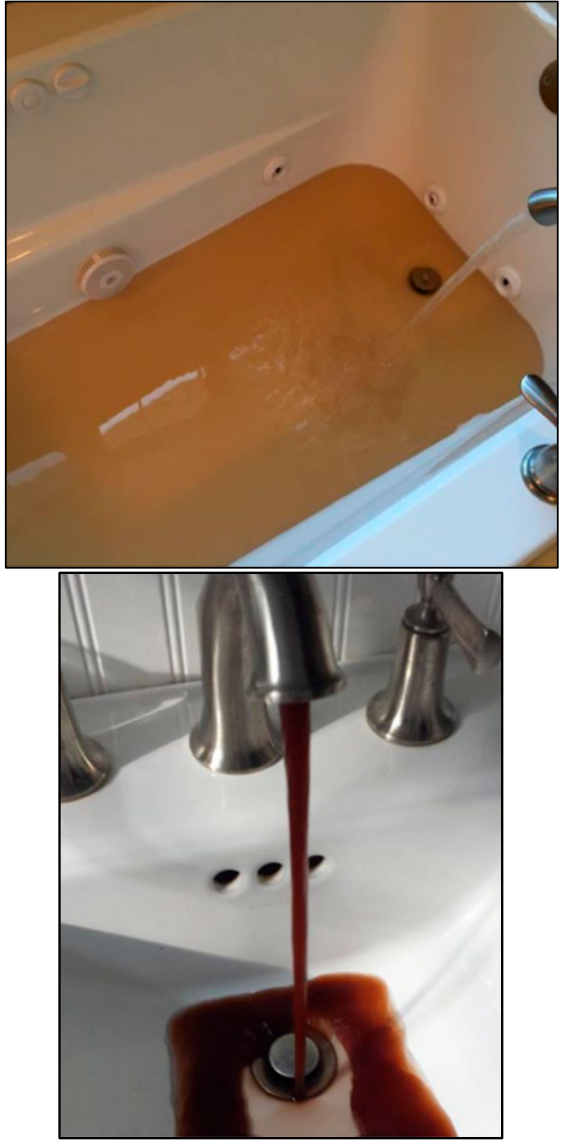
Figure 2. Photos of discolored tap water in Holliston homes, posted on Facebook ® by Holliston